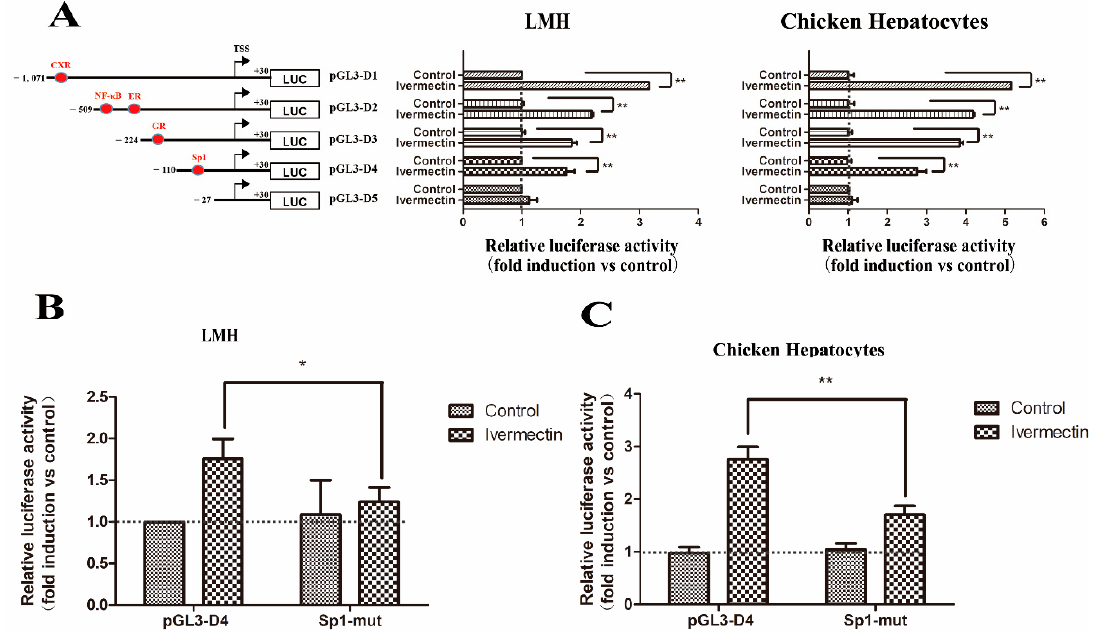
Figure 8. Regulation of chicken Abcg2 promoter activity by ivermectin. ( A ) Isolation of the promoter elements responsible for mediating the stimulation of the Abcg2 gene promoter activity by ivermectin. LMH cells and chicken hepatocytes were transfected with deletion constructs of the Abcg2 promoter. A schematic illustration of the Abcg2 gene promoter reporter plasmids used is shown in the left panel.